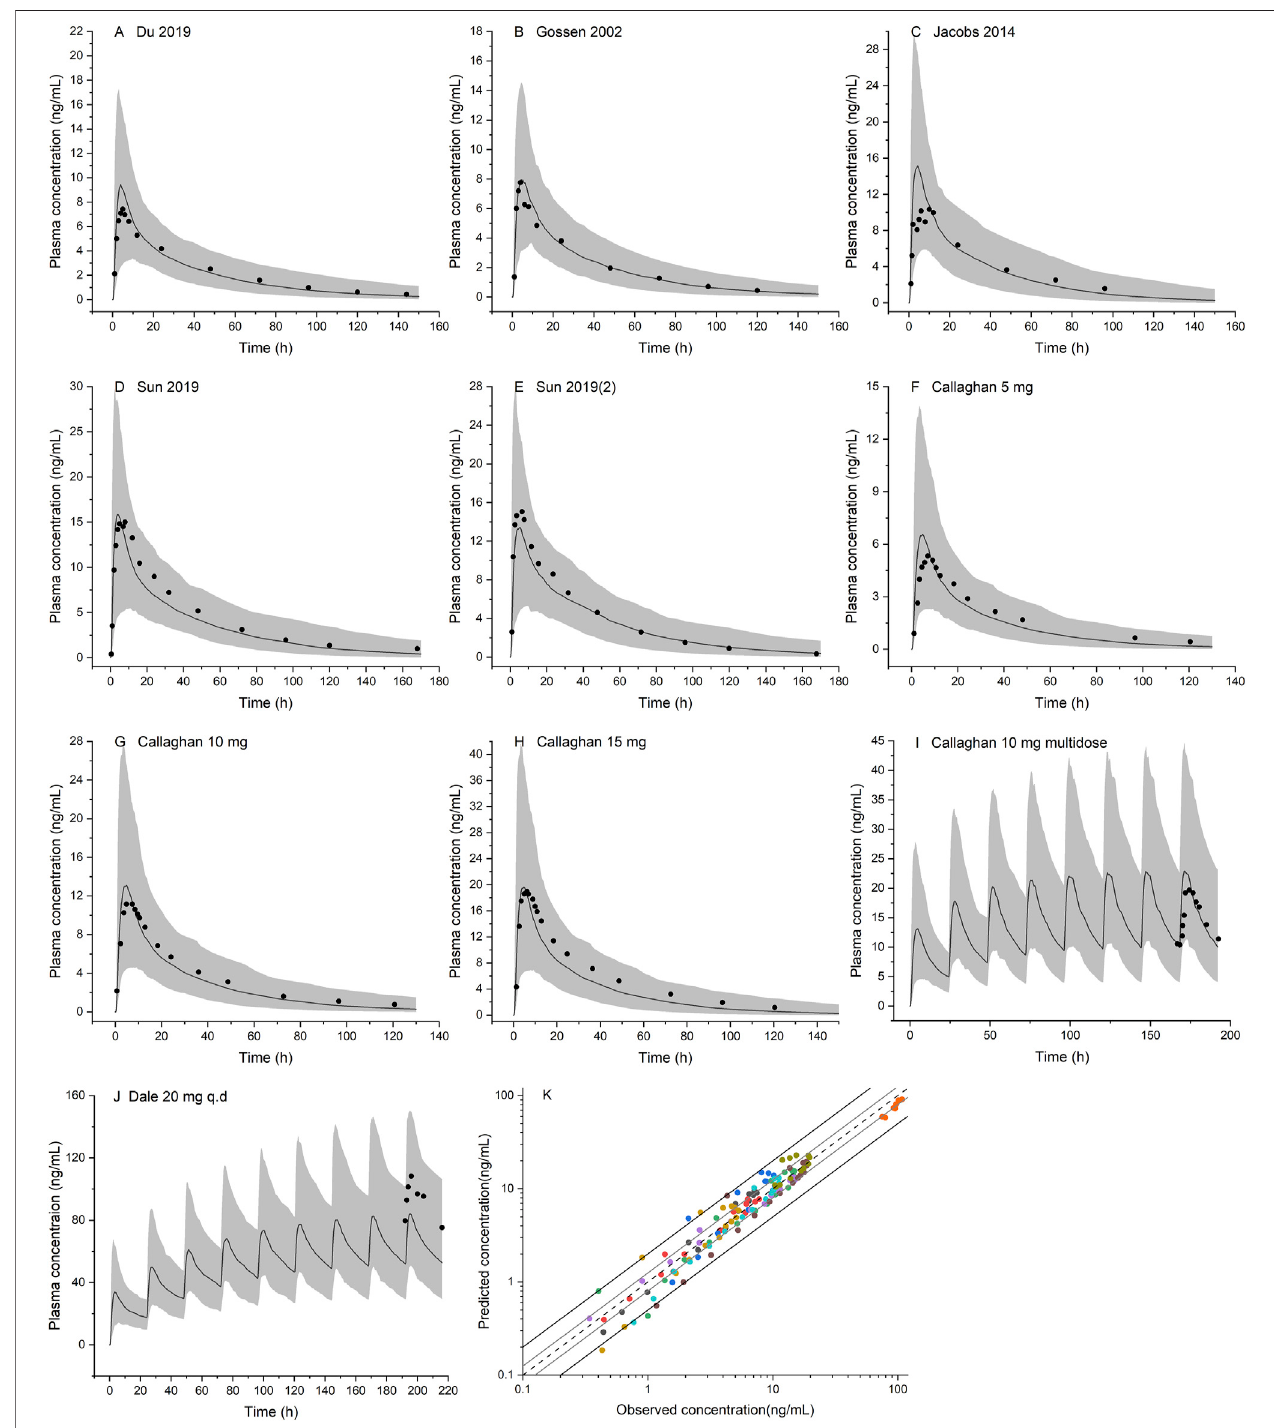
FIGURE5| Population PBPK simulations for olanzapine in the non-pregnant population (A – J) Predicted median plasma concentrations are shown as dark lines, and shaded areas indicate 5th to 95th prediction range. Black dots are observed mean plasma concentrations extracted from clinical studies (K) Goodness of fi t plot for model prediction of olanzapine plasma concentrations. Different colors represent observed-to-predicted concentration data from different simulations in fi gure A – J . The observed data are from published studies with references provided in the Supplementary Material .